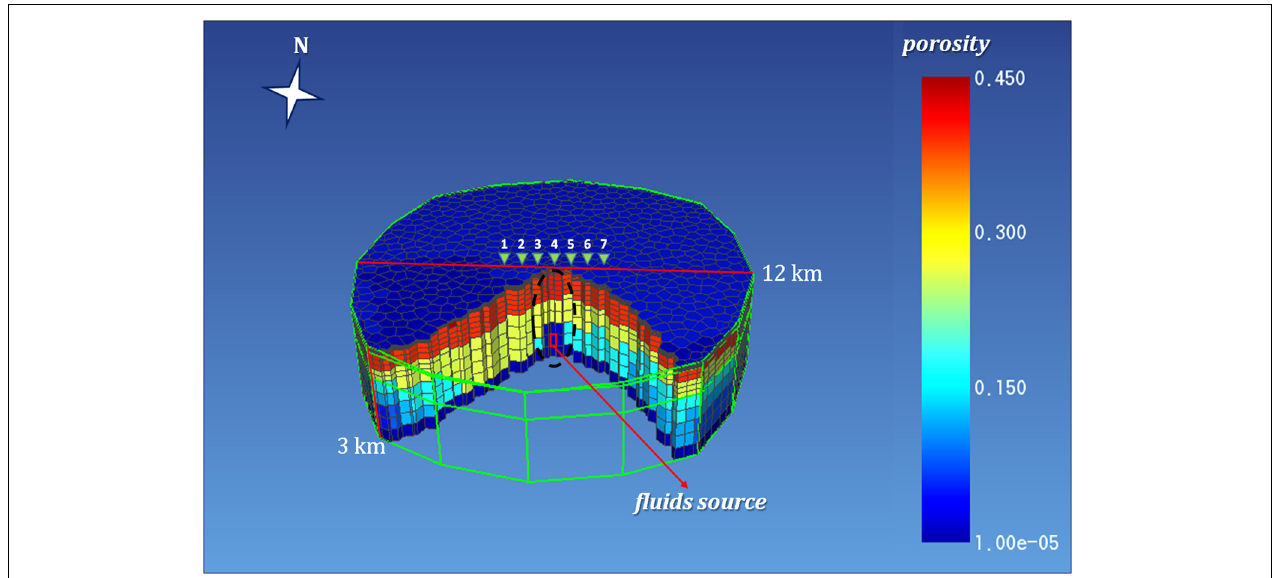
FIGURE 3 | Campi Flegrei model shown in terms of porosity distribution. The red line indicates the profile along which the synthetic MT response at the stations 1–7 has been calculated. The black dashed ellipse indicates the portion of the hydrothermal system whose permeability values have been changed to simulate the effect of a permeability increase on the system dynamics (see section “Scenario II: Effect of Permeability